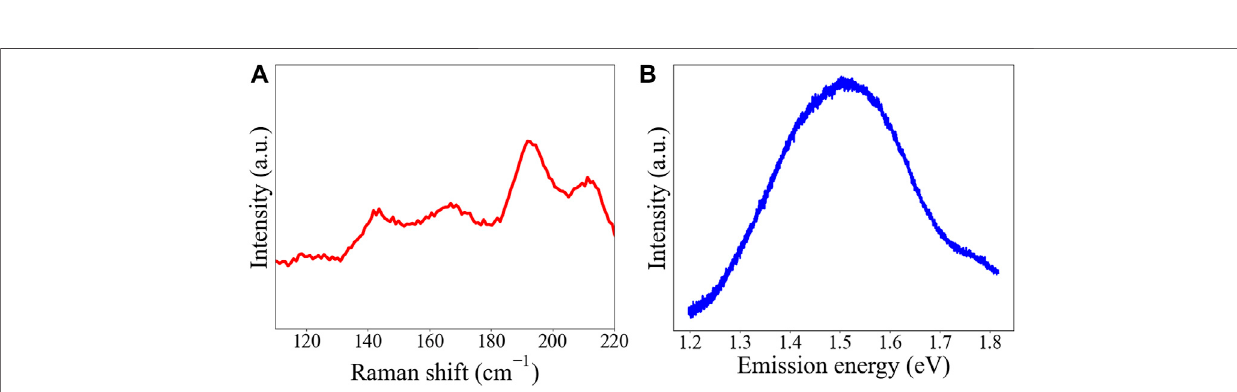
FIGURE 2 | Material characterization of monolayer ReSe 2 . (A) Raman shift spectra and (B) photoluminescence.